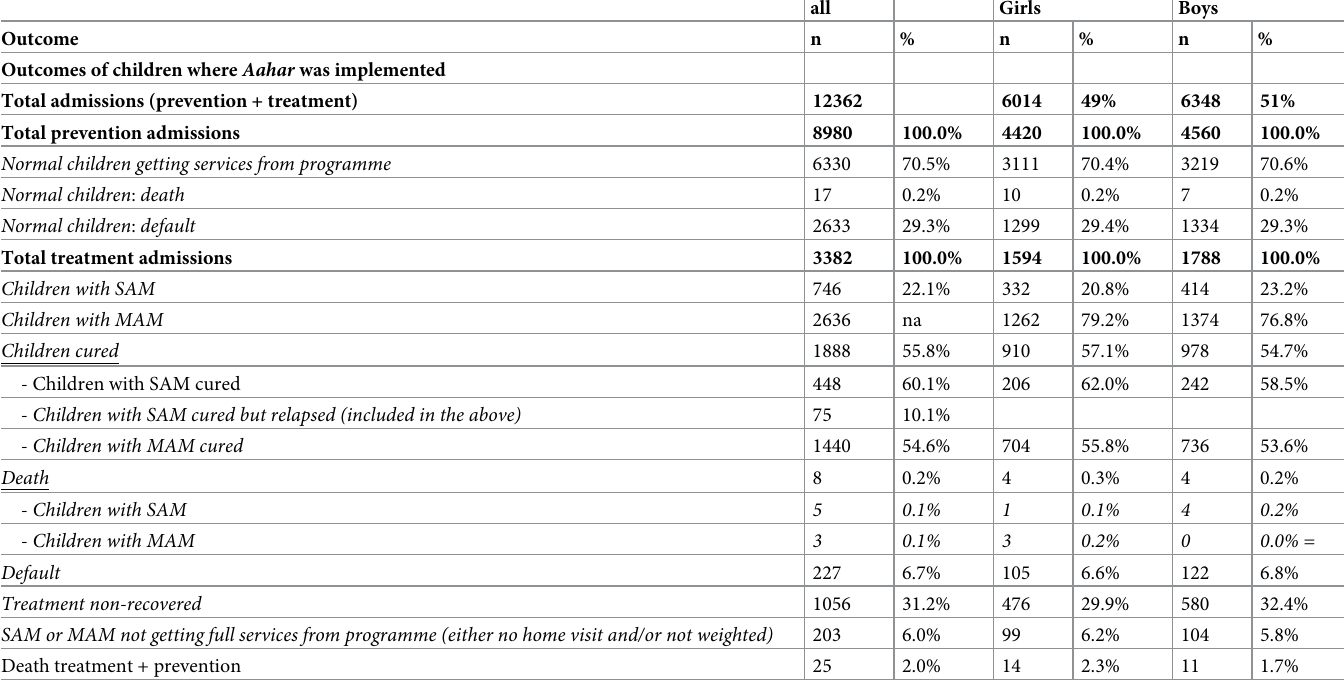
Table 1. Treatment and prevention outcomes for Aahar acute malnutrition programme programme for girls and boys (admission, cured, death, default and relapse